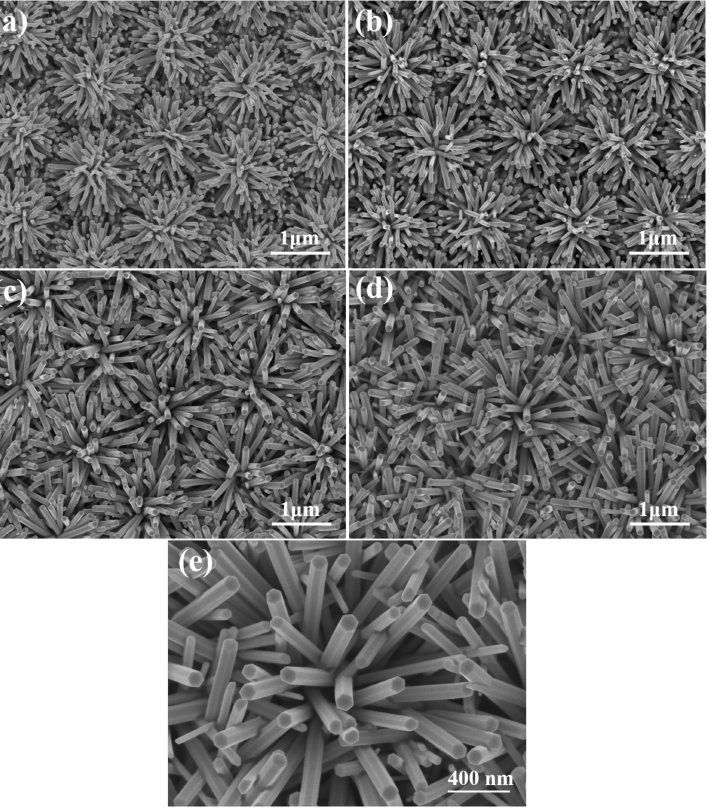
Figure 4. ZnO NFAs synthesized at ( a ) 10, ( b ) 20, ( c ) 30, and ( d ) 60 min. ( e ) 60 min-synthesized ZnO NFAs with higher